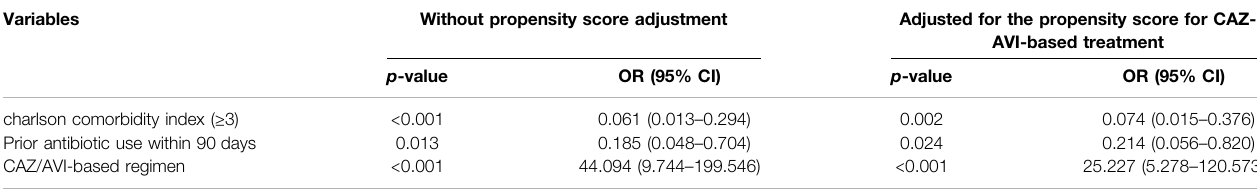
TABLE 4 | Binary logistic regression analysis of risk factors for patients with CRKP infection for 7-day microbiological clearance. Variables Without propensity score adjustment Adjusted for the propensity score for CAZ-